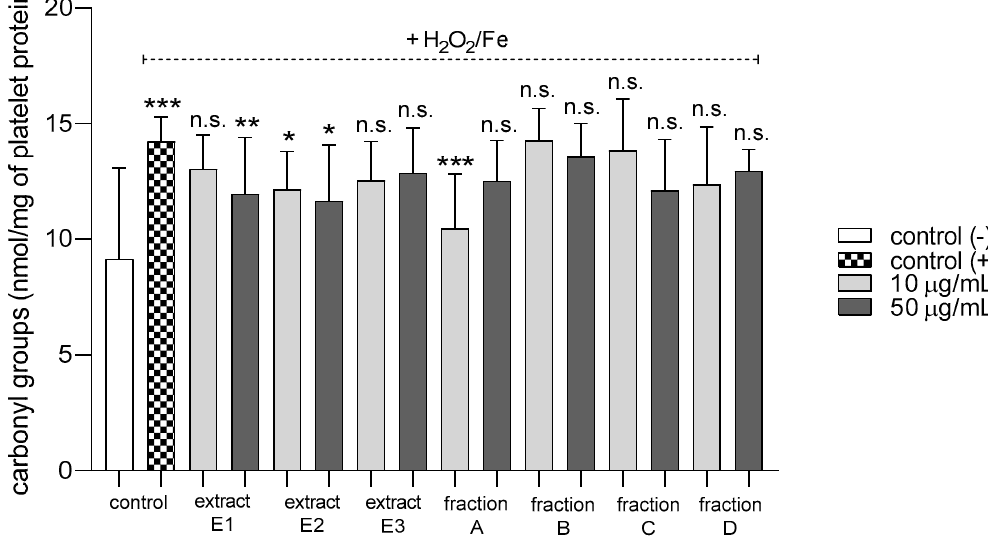
Figure 7. Effects of extracts (E1–E3) and flavonoid fractions (A–D) of dandelion fruits (concentrations 10 and 50 µg/mL) on the level of carbonyl groups in platelet protein treated with H2O2/Fe. The data are presented as means ± SD ( n = 5). Control negative refers to platelets not treated with H 2 O 2 /Fe, and control positive to platelets treated with H 2 O 2 /Fe. Kruskal-Wallis test: n.s. p > 0.05, * p < 0.05, ** p < 0.01, *** p < 0.001, compared with positive control.